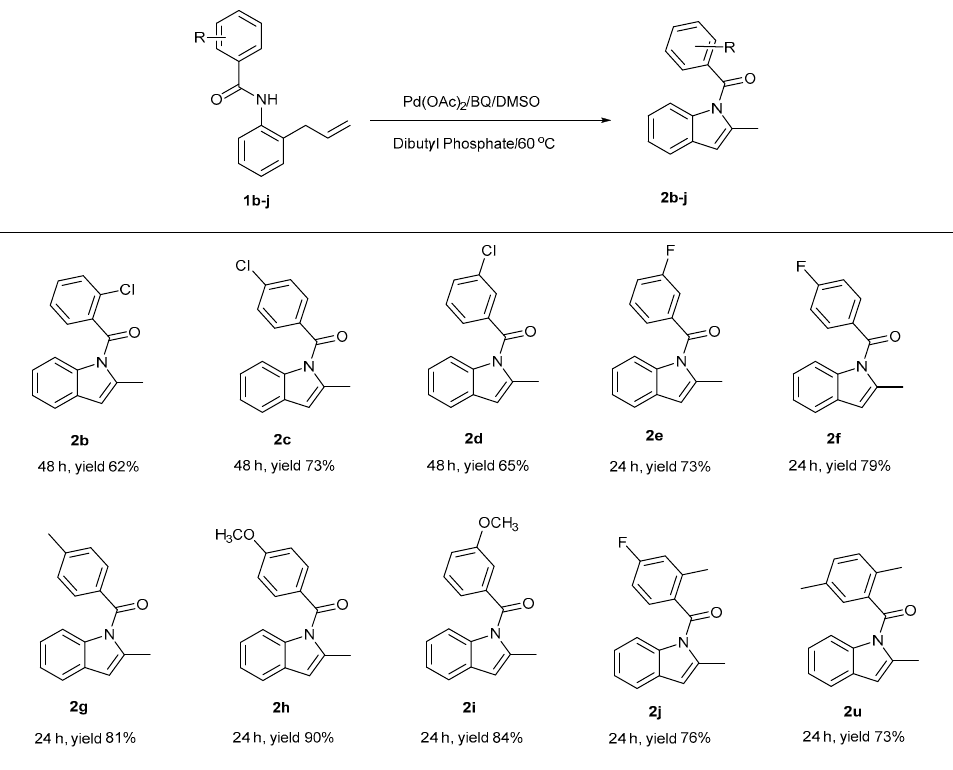
Table 3. Substrate scope of substrates with substituents at the positions (R 1 ). a, b. Conditions: See Supplementary Materials for details.